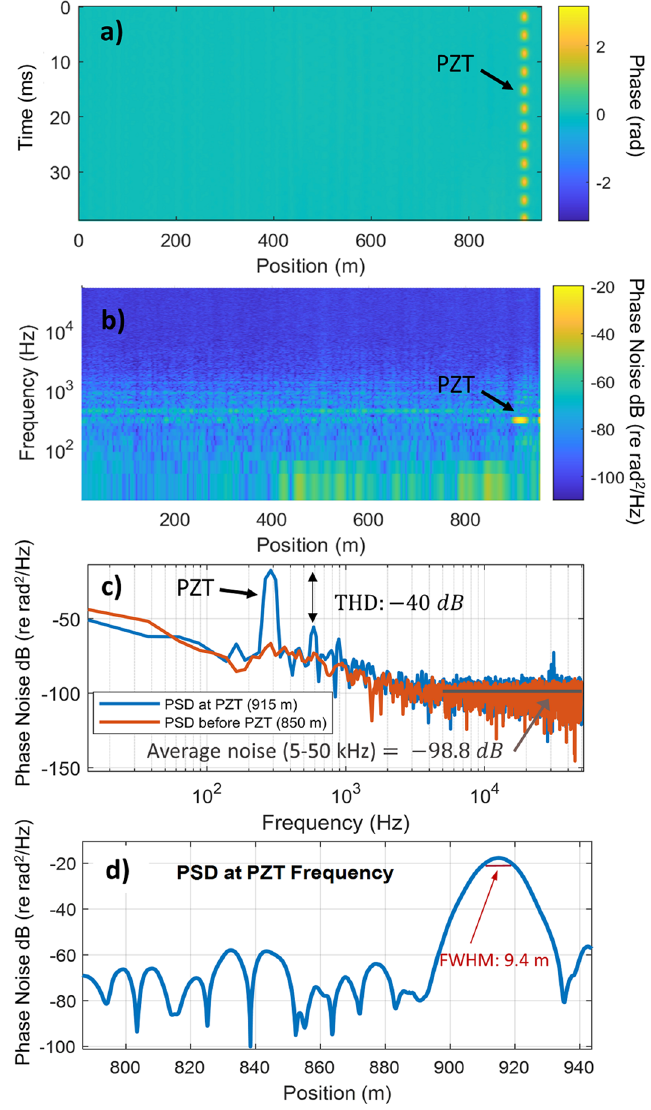
Figure 4. Typical measurement obtained using a train of 20 pulses and a 1 km FUT. ( a ) Temporal evolution of the phase at each position in the fiber, showing the modulation introduced by the PZT. ( b ) Spectrogram showing the PSD at each position in the fiber. ( c ) The phase PSD at the PZT position, confirming that the PZT modulation was measured with a high degree of linearity. The average phase noise (in the frequency range of 5–50 kHz) is shown as a solid horizontal line. ( d ) Cross-section of the PSD at the PZT frequency versus position. The PZT signal is measured at 915 m with a FWHM of 9.4 m indicated by the red solid